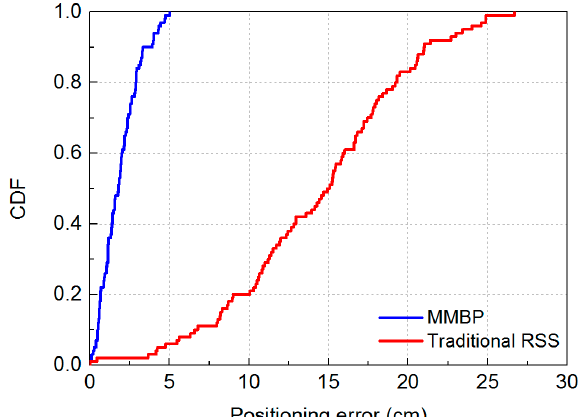
Figure 14. Distribution of positioning error for ( a ) MMBP algorithm with arbitrary training data set and ( b ) traditional RSS-based algorithm.